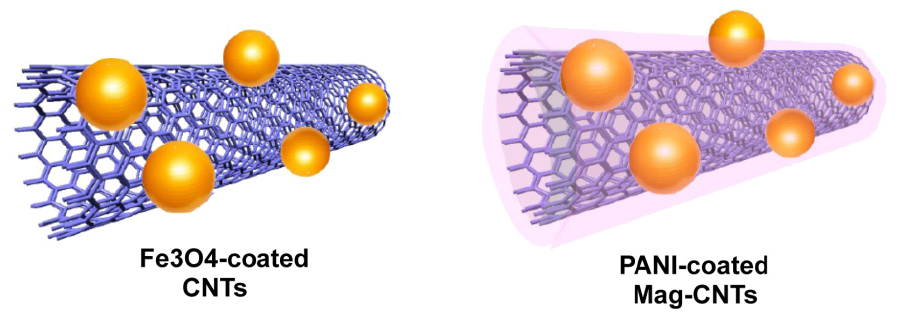
O /CNTs ( right 3 4